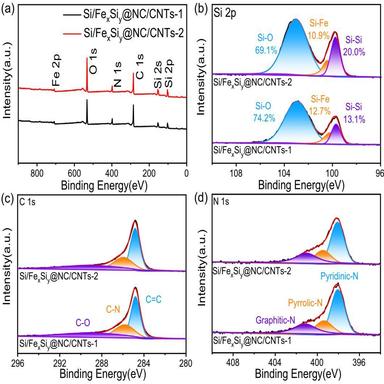
The XPS spectrum of Si/FexSiy@NC/CNTs-1 and Si/FexSiy@NC/CNTs-2, (a) Full spectrum, (b) Si 2p, (c) C 1s, and (d) N 1s.